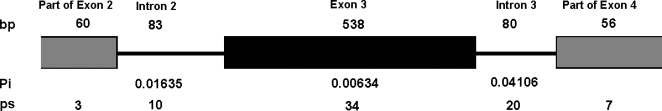
Genomic structure and polymorphism of partial sequences of the A. gambiae ace-1 gene.bp: number of bases for each sequence. Pi: Nucleotide diversity. ps: Number of polymorphic sites.